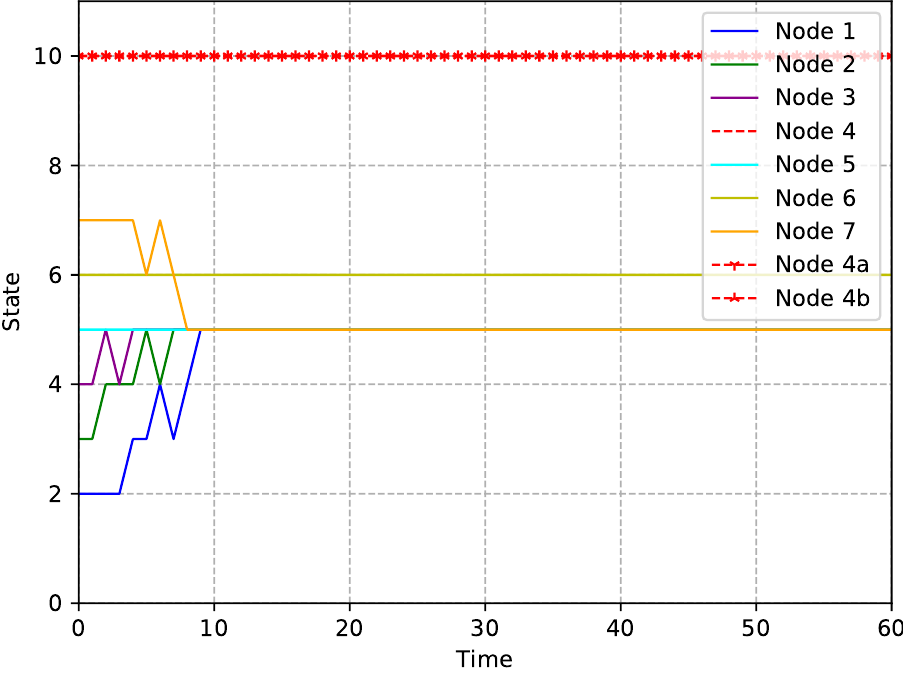
Figure 11. Simulation results of proposed algorithm under strongly connected